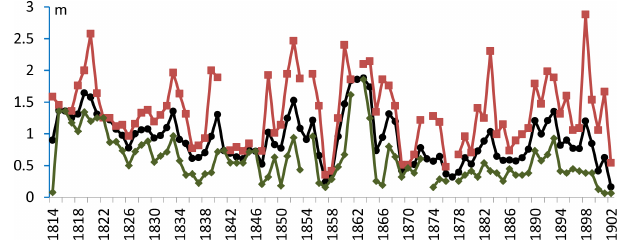
Figure 2. Annual mean (thick black line with dots), maximum (thin brown line with squares) and minimum (thin green line with di- amonds) water levels of Lake Machang over the period of 1814– 1902.